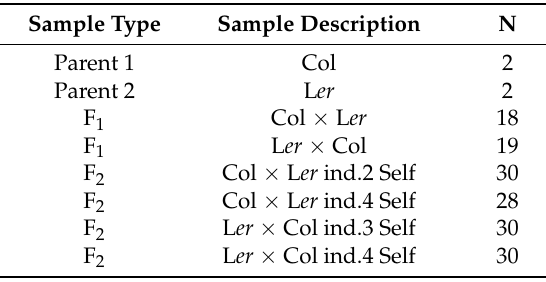
Table 1. The number of samples used for